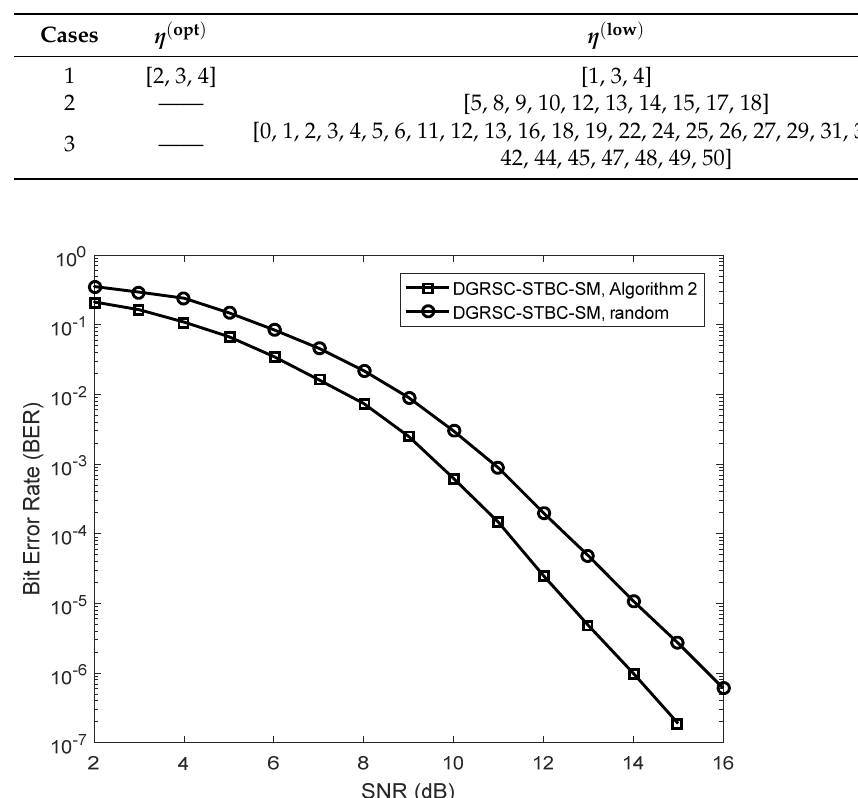
Figure 5. Error performance for DGRSC − STBC − SM using C S ( 25, 19, 7 ) and C R ( 25, 10, 16 ) under different selection algorithms, N t = 3, N r = 4 and 4 −